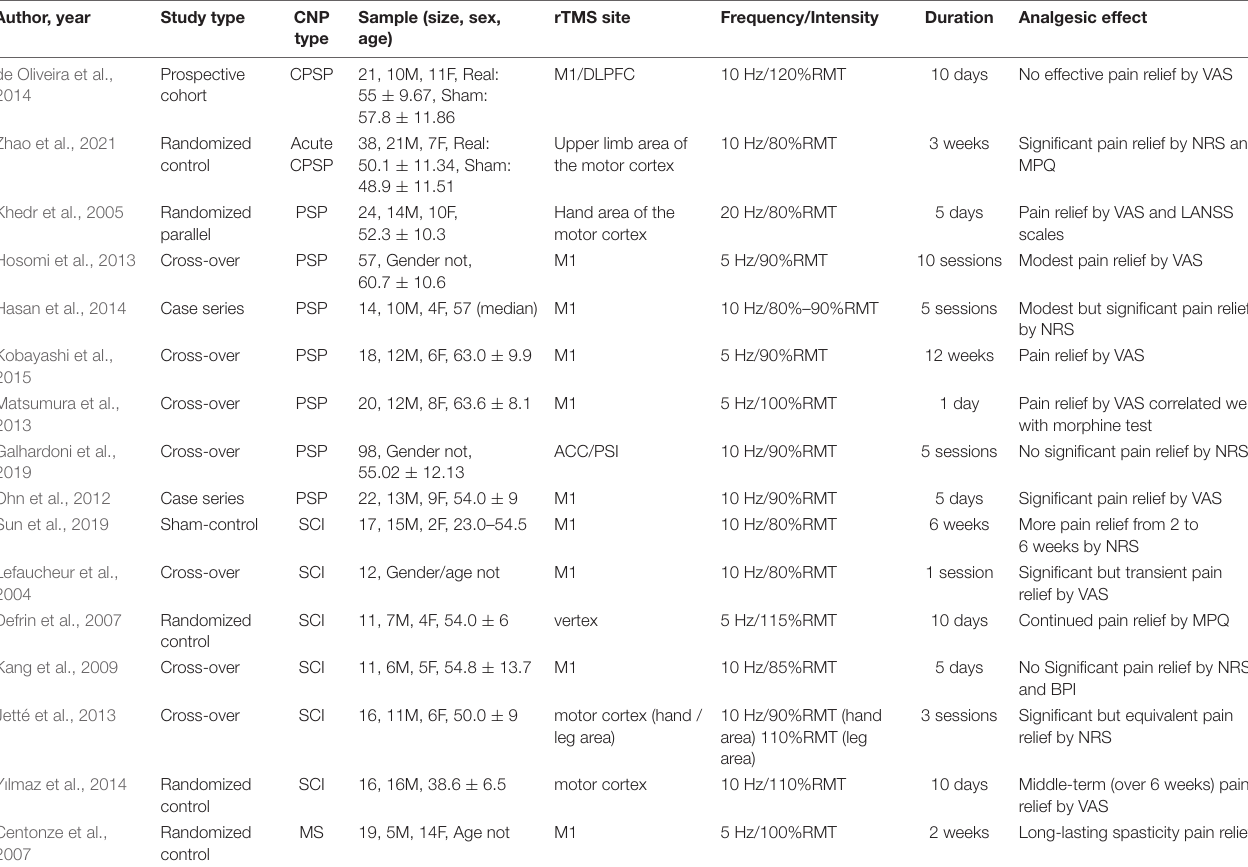
TABLE 1 | Major findings of Repetitive transcranial magnetic stimulation (rTMS) in central neuropathic pain (CNP)